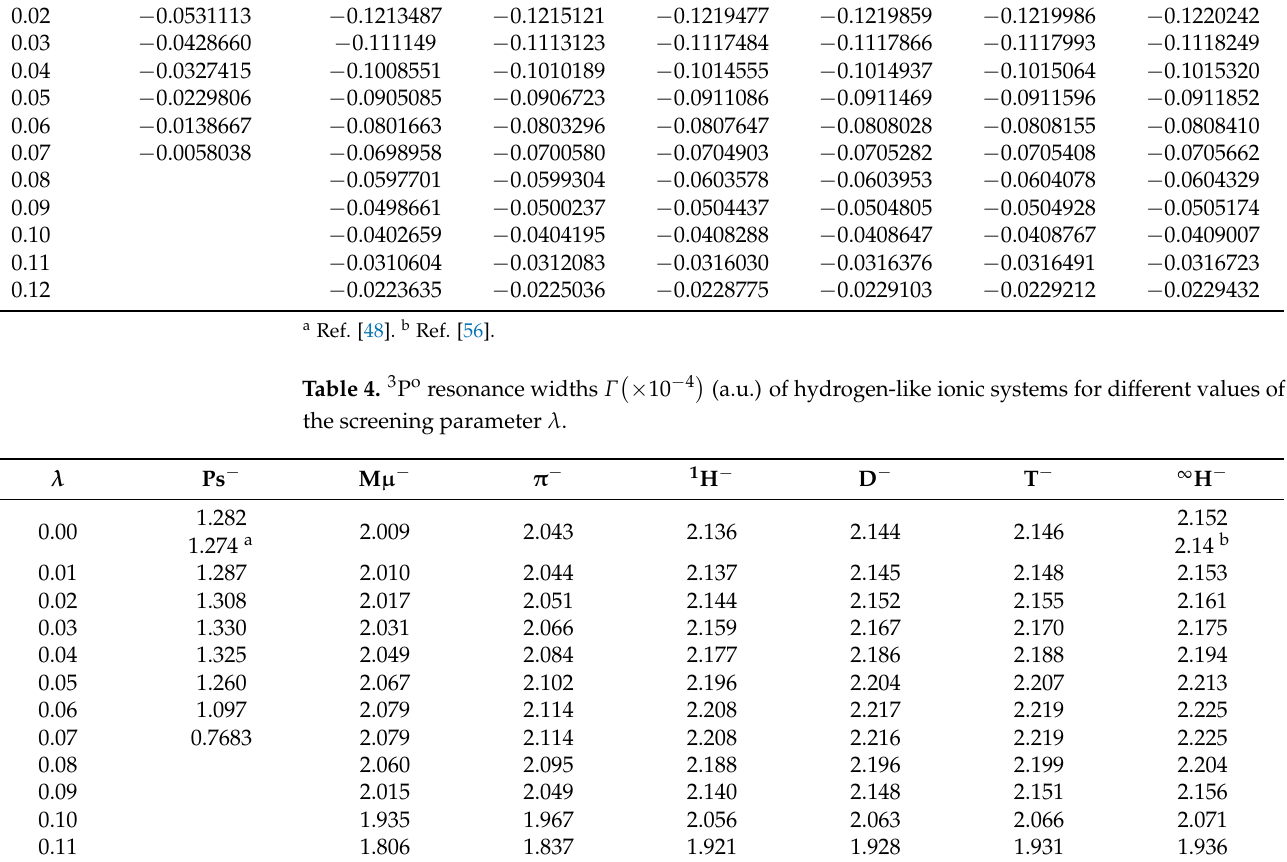
Table 3. 3 P o resonance energies E r (a.u.) of negative hydrogen-like ions immersed in a quantum plasma environment for different values of the screening parameter λ .